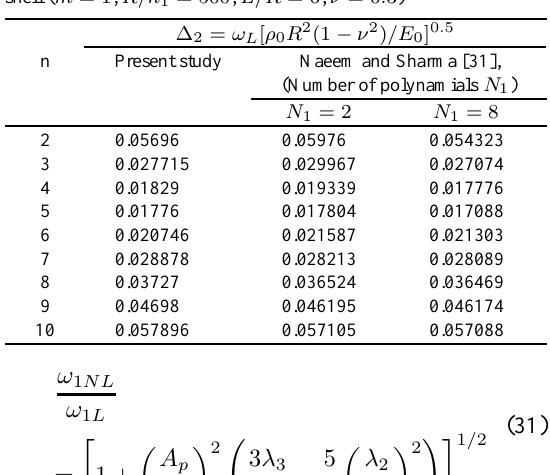
Table 2 Comparison of frequency parameters ∆ 2 for an isotropic cylindrical shell ( m = 1 , R/h 1 = 500 , L/R = 6 , ν = 0 . 3